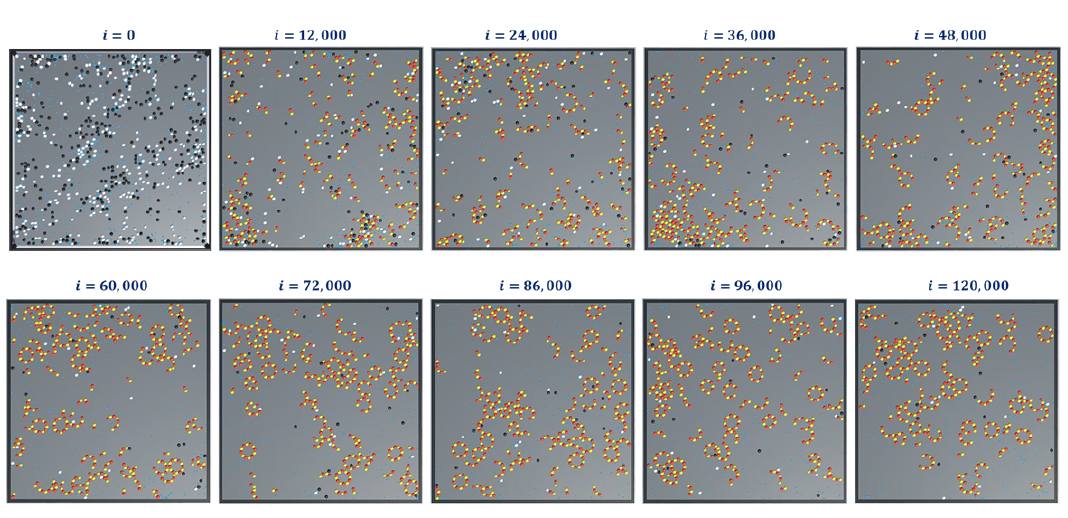
Figure 14. Snapshots of simulation-3 showing formation of rings from tubulins. The simulation was run for 300 of each of α and β tubulins, 600 GTPs, P GTP = 1, 120,000 iterations and with no extended rules. Multiple closed and open rings can be observed in the end.